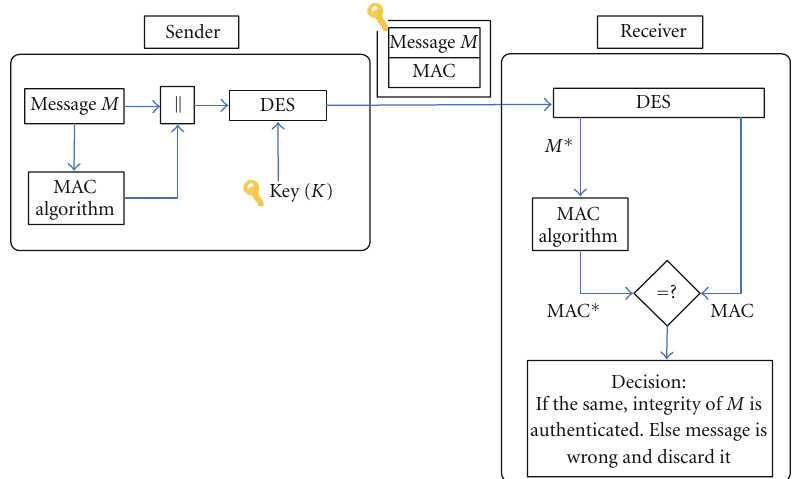
Figure 1: Message authentication